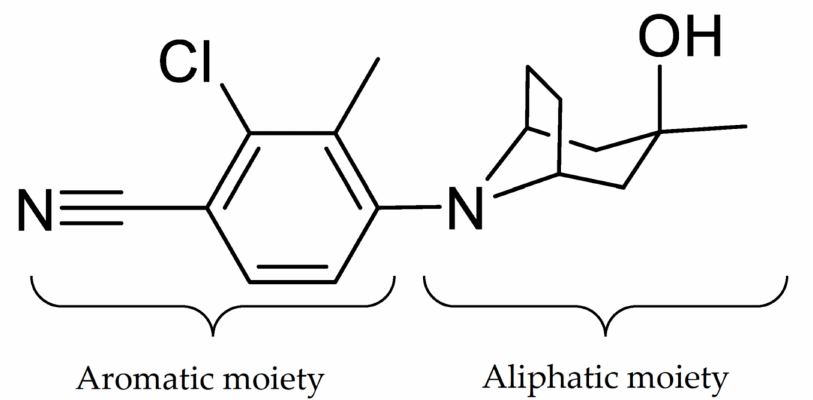
Figure 1. The structure of ACP-105 (2-chloro-4-[(3-endo)-3-hydroxy-3-methyl-8-azabicyclo[3.2.1]oct- 8-yl]-3-methylbenzonitrile).